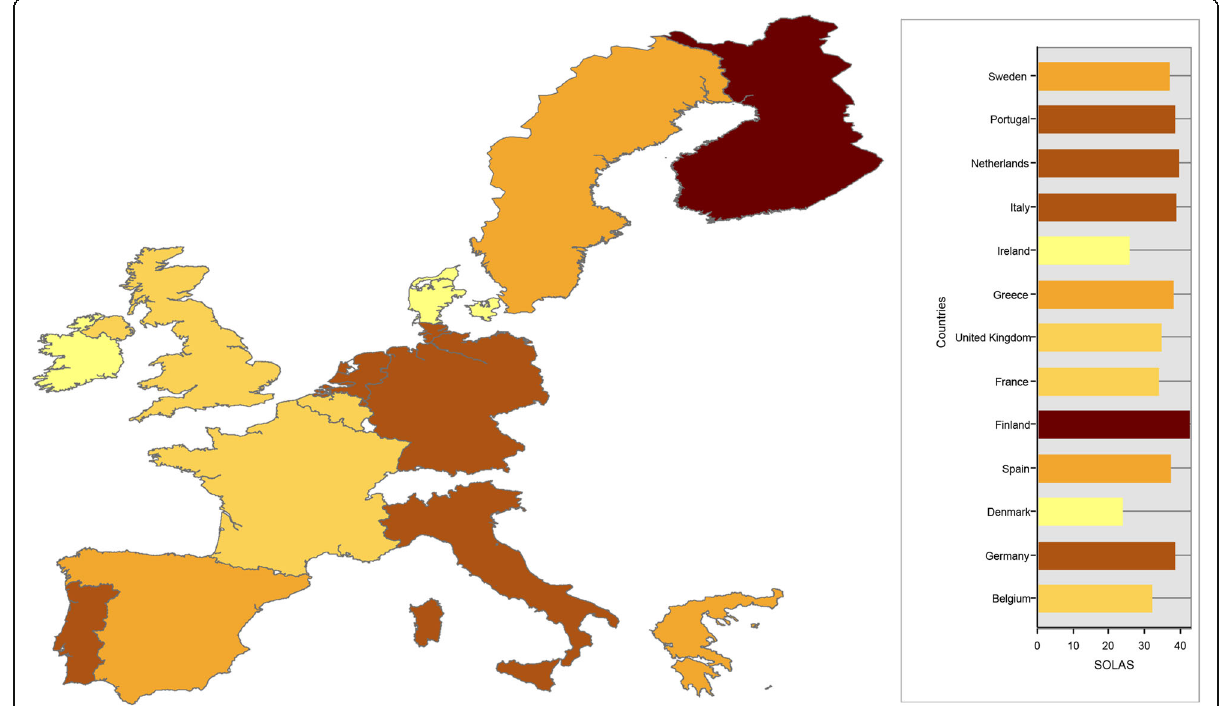
Fig. 5 The weighting of SOLAS Convention deficiencies as a result of AHP